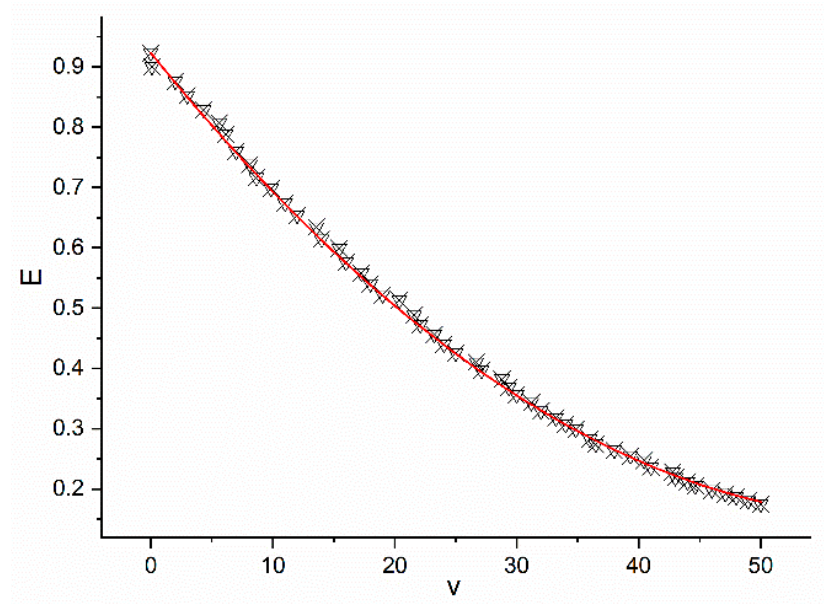
Figure 8. Relationship between carbon emissions and velocity.